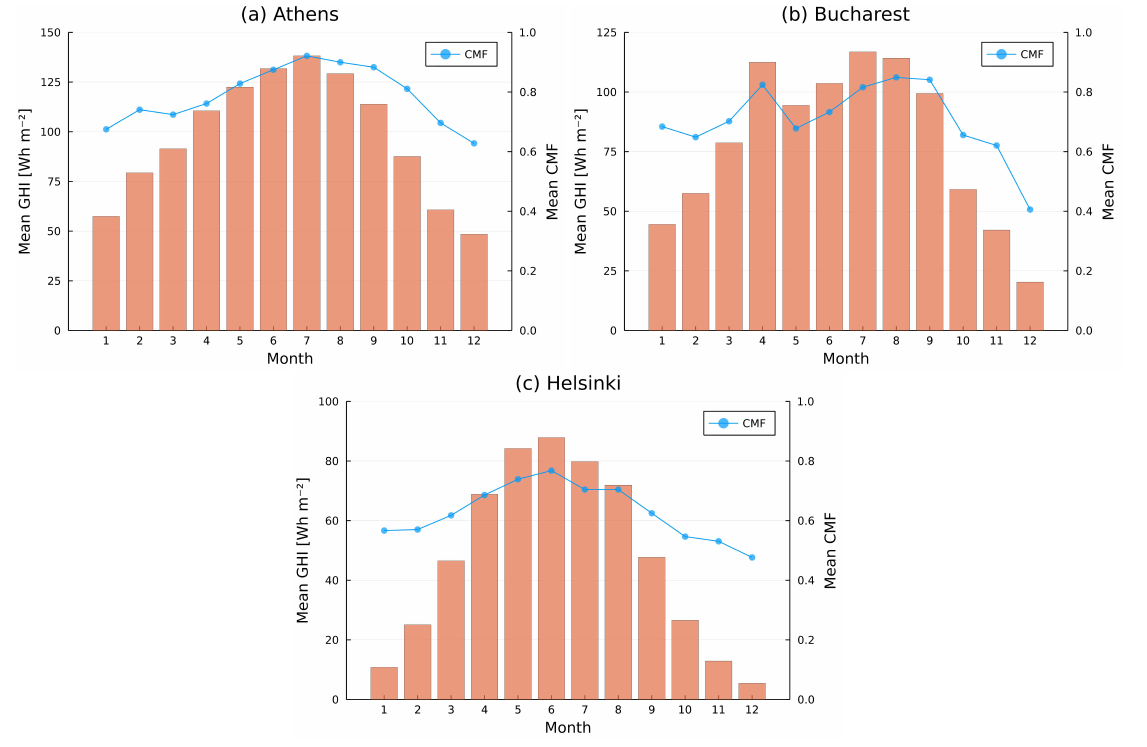
Figure A1. Daily mean global horizontal irradiation (GHI) for each month (orange bars, left axis) and monthly mean cloud modification factor (CMF; blue curves, right axis) in 2020 for ( a ) Athens, ( b ) Bucharest, and ( c ) Helsinki.